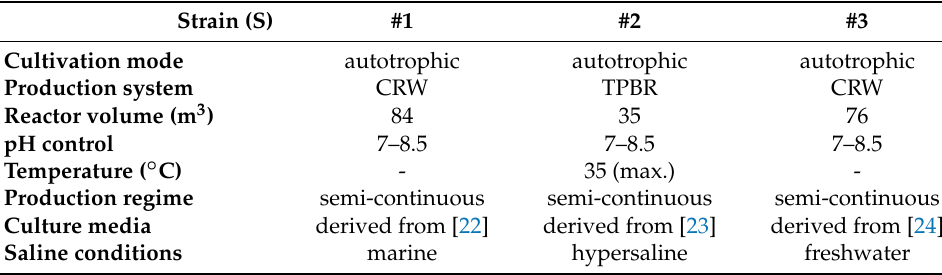
Table 1. Process conditions used for microalgae cultivation. Strain (S) #1 #2